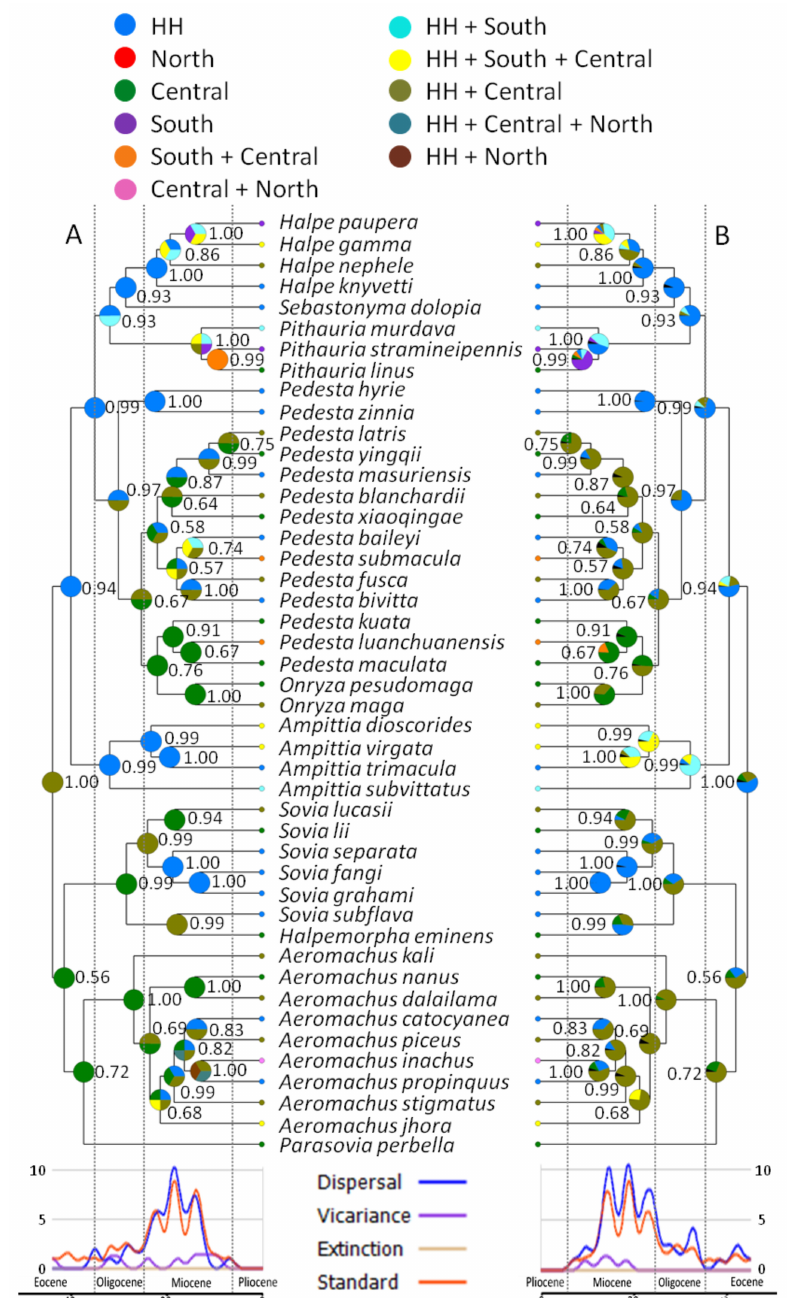
Figure 4. Biogeographic inference recovered with: ( A ) statistical dispersal-vicariance analysis (S-DIVA); and ( B ) Bayesian binary MCMC (BBM) in RASP 2.0. Pie charts represent the marginal probabilities for each alternative ancestral area: HH, Himalaya-Hengduan Mountains Region; South, Southern China Region; Central, Central China Region; and North, Northern China